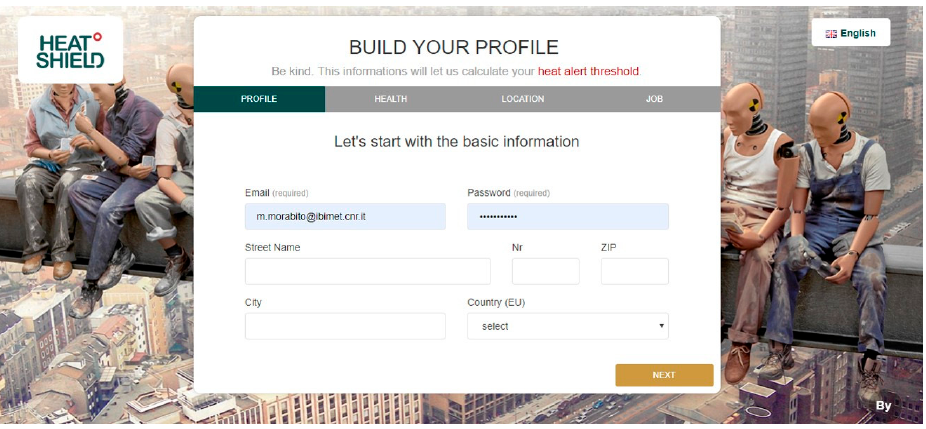
Figure 4. Registration page to create your own profile of personalized heat stress warnings.